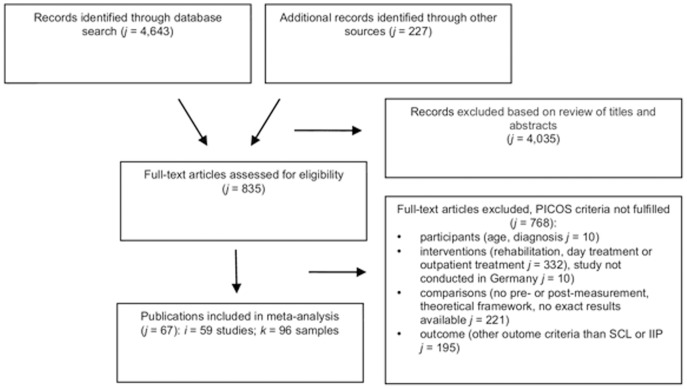
Study Flow Chart.